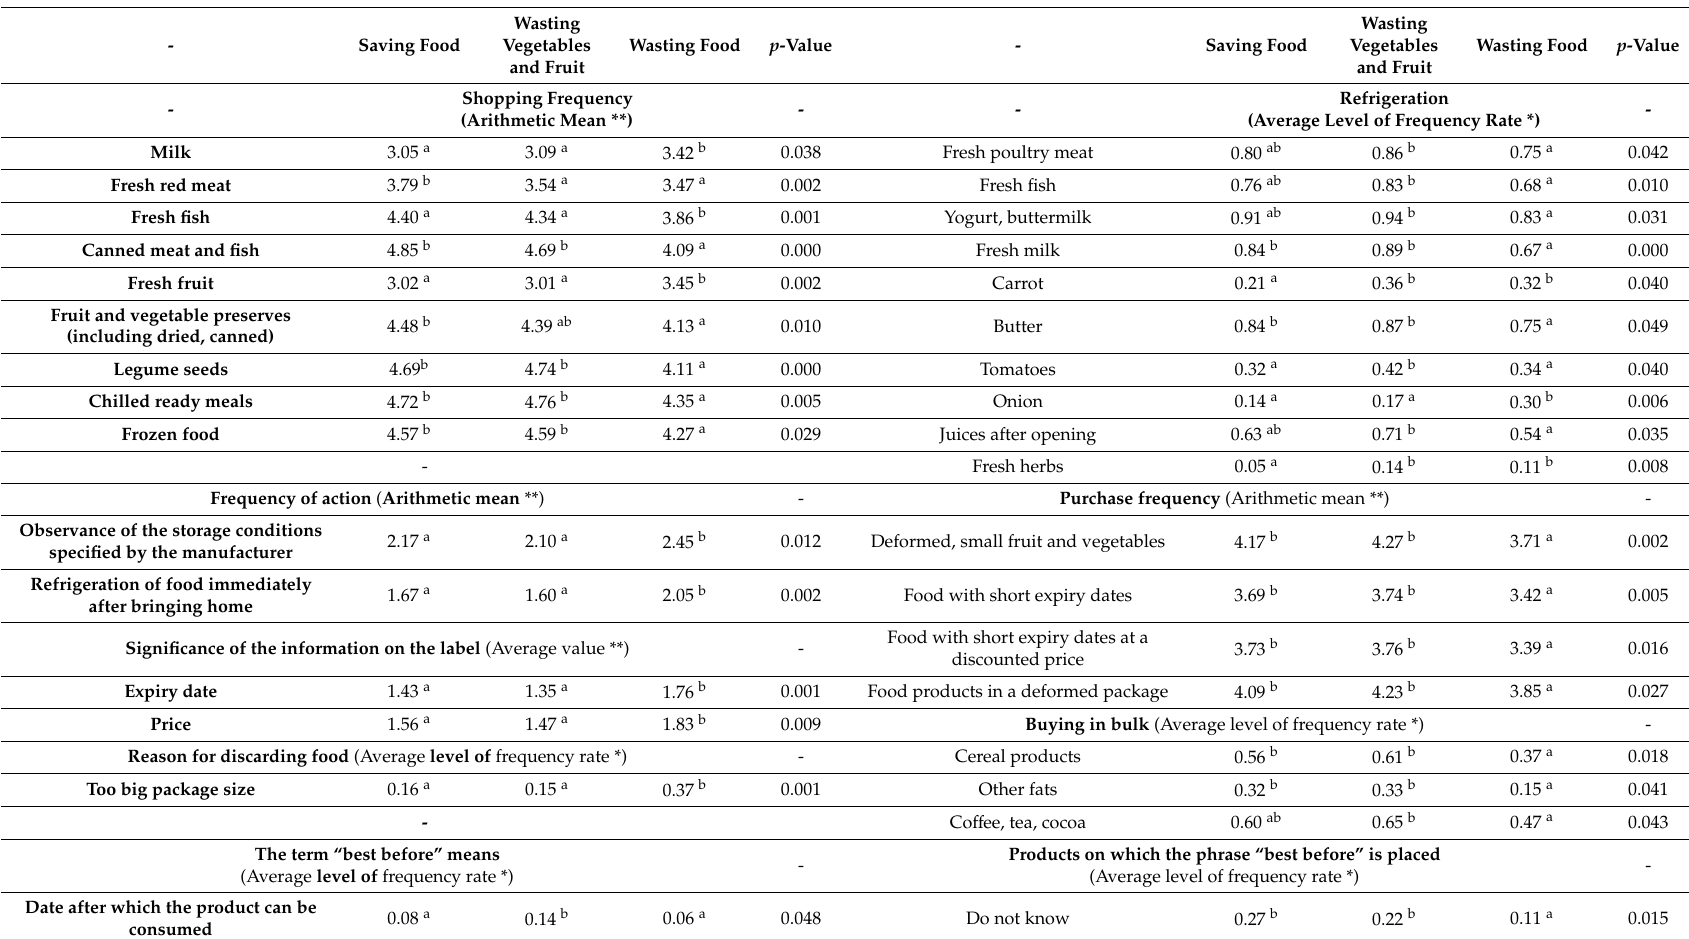
Table 3. Selected aspects of food handling for the identified segments, average level of frequency rate, arithmetic mean and the results of the variance analysis and the LSD